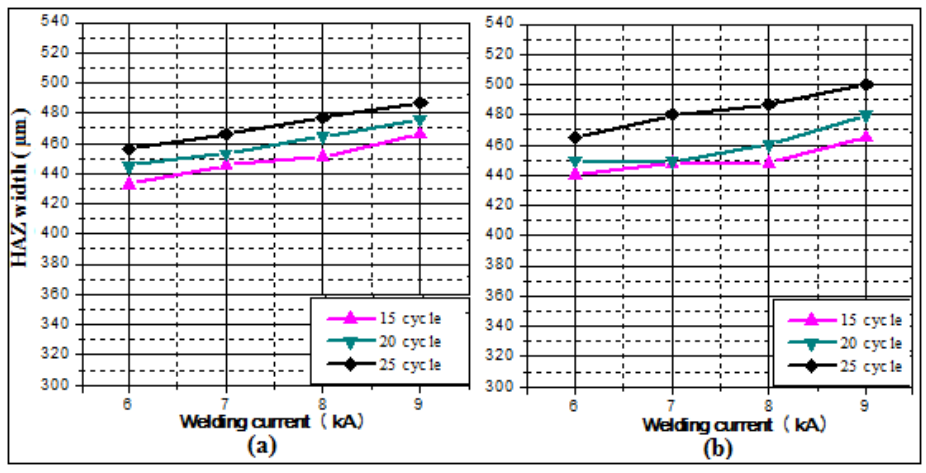
Figure 5. Effect of welding parameters on the width of the HAZ: ( a ) uncoated; ( b ) galvanized.